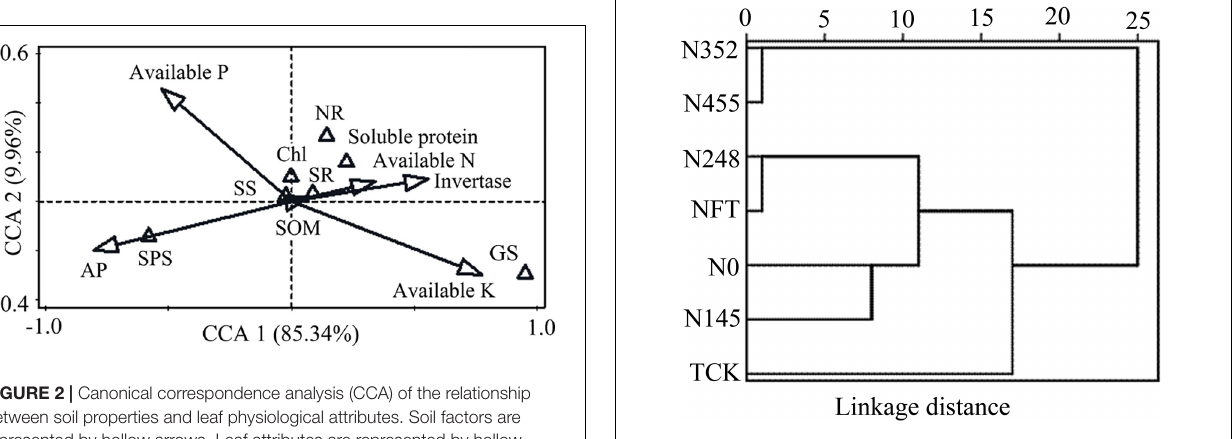
Frontiers in Plant Science |